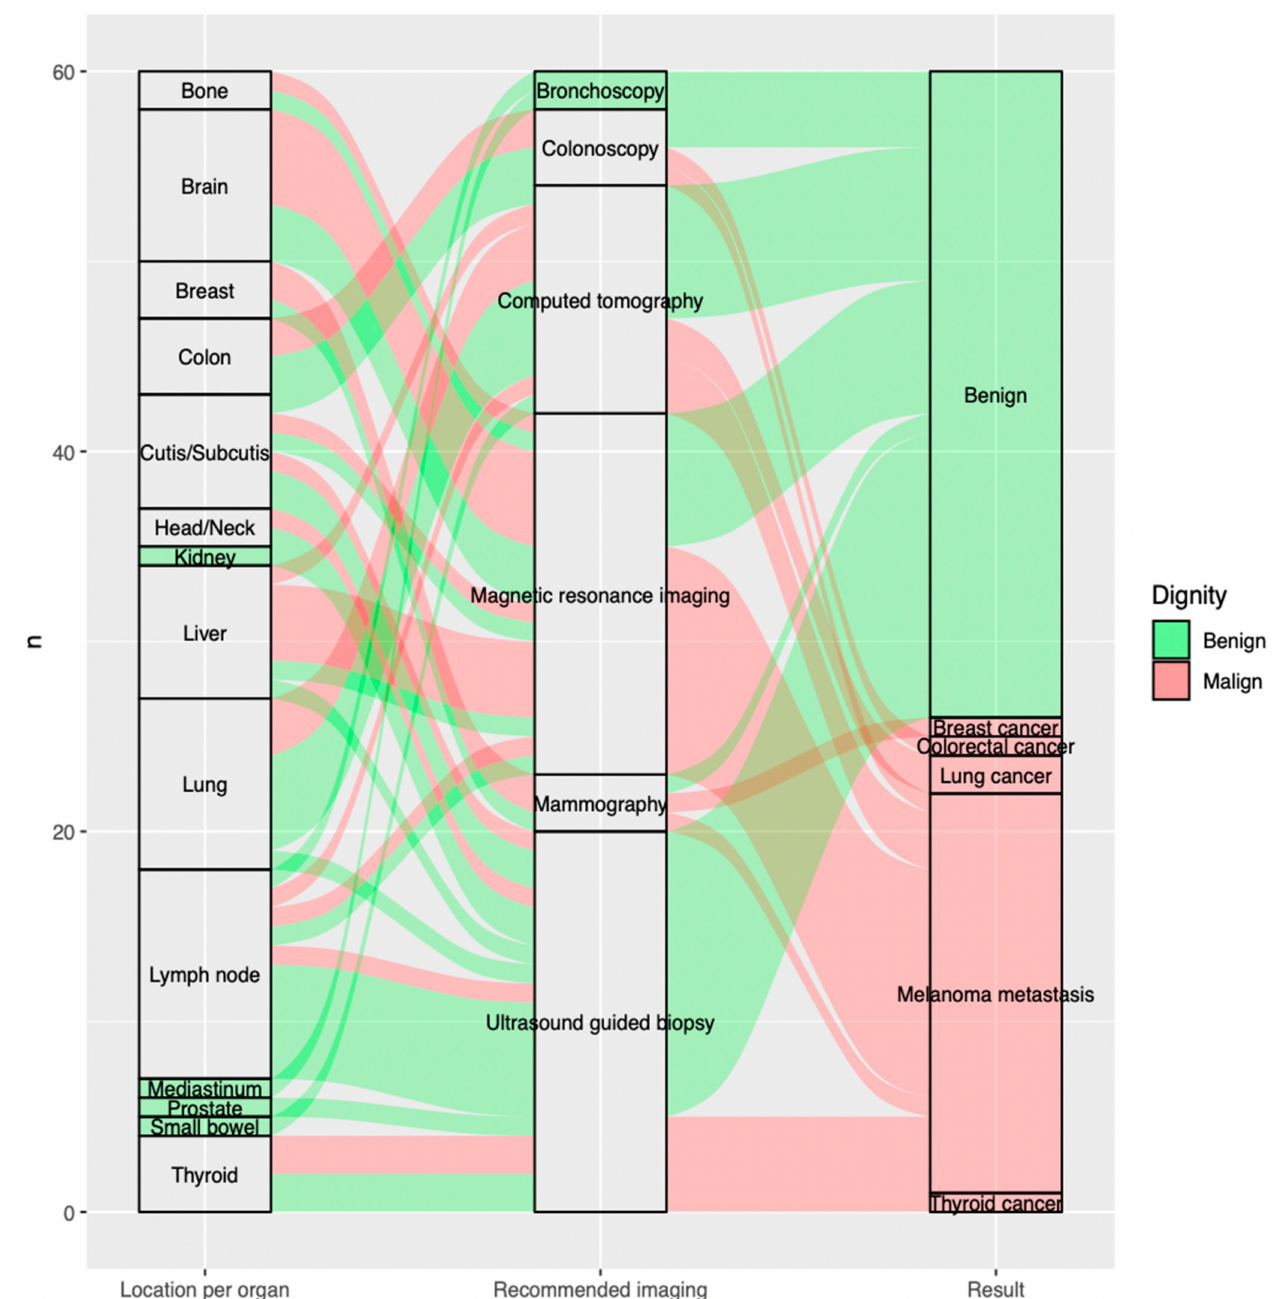
Figure 2. Sankey plot showing, per included indeterminate finding on the FDG-PET/CT ( n = 60), on the far left, ( a ) location per organ; in the middle, ( b ) recommended imaging for further evaluation; and the far right, ( c ) outcome of additional imaging. Benign findings are displayed in green, malign findings in red arrows. ( a ) Location per organ (on the left from the bottom to the top): thyroid ( n = 4; 5.0%, small bowel ( n = 1; 1.7%), prostate ( n = 1; 1.7%), mediastinum ( n = 1; 1.7%), lymph node ( n = 11; 18.3%), lung ( n = 9; 15.0%), liver ( n = 7; 11.7%), kidney ( n = 1; 1.7%), head/neck ( n = 2; 3.3%), cutis/subcutis ( n = 6; 10.0%), colon ( n = 4; 6.7%), breast ( n = 3; 5.0%), brain ( n = 8; 13.3%), bone ( n = 2; 3.3%). ( b ) Recommended imaging (in the middle from the bottom to the top): ultrasound guided biopsy ( n = 20; 33.3%), mammography ( n = 3; 5.0%), magnetic resonance imaging ( n = 19; 31.7%), computed tomography ( n = 12; 20.0%), colonoscopy ( n = 4; 6.7%), bronchoscopy ( n = 2; 3.3%). ( c ) Result (on the right from the bottom to the top): thyroid cancer ( n = 1; 1.7%), melanoma metastasis ( n = 21; 35.0%), lung cancer ( n = 2; 3.3%), colorectal cancer ( n = 1; 1.7%), breast cancer ( n = 1; 1.7%), benign ( n = 34;